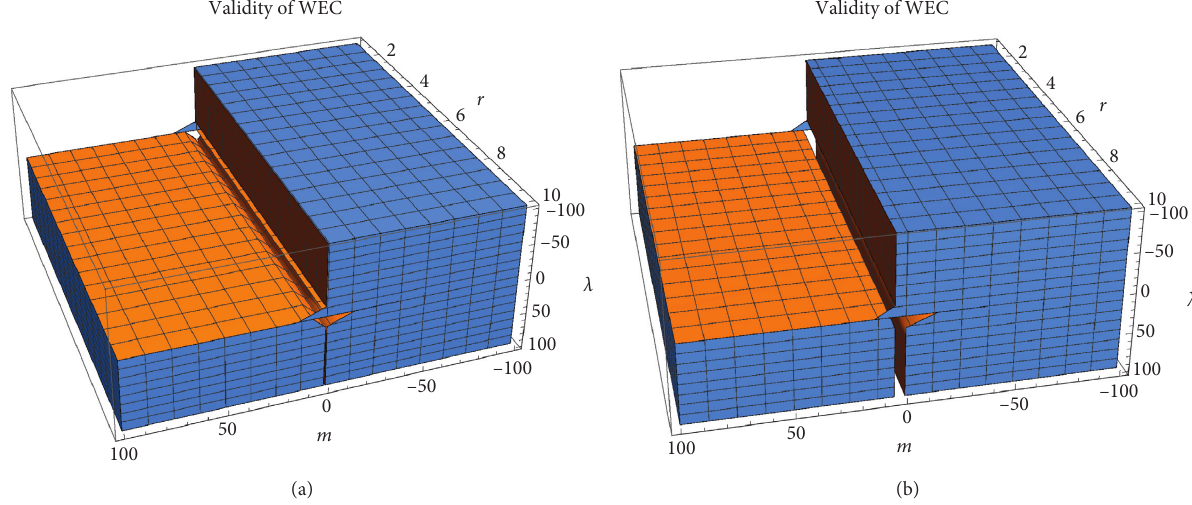
Figure 1: Variation of energy constraint for f ( R , T ) model with the quadratic term in trace T using α > 0 , c > 0. The left plot indicates the possible regions of WEC for β > 0, where we fix β � 2 and take the variations of m and λ . In the right plot, viability regions of WEC for β < 0 are provided, where we select β � −